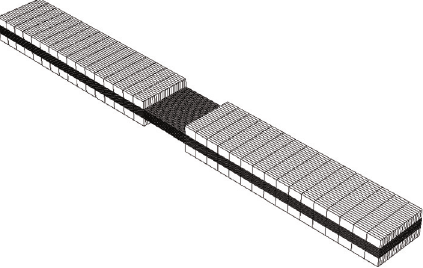
Figure 14: Damage evolution law in shear.